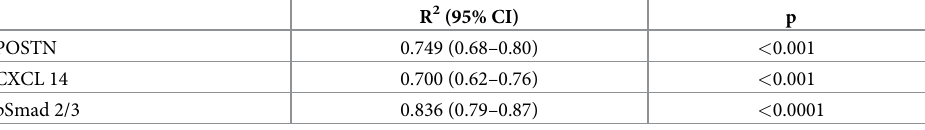
Table 2. Correlations between scorer 1 and scorer 2 for each protein expression